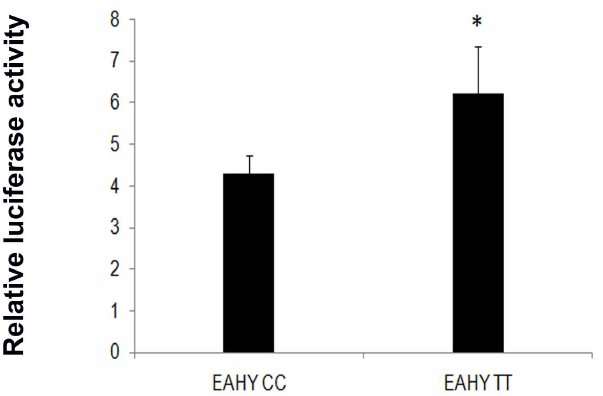
Figure 4. Effect of FoxC2 variant c.-512C . T (rs34221221) on luciferase expression in EA.hy926 cells. Cell lines were transiently transfected with the FoxC2 promoter reporter plasmid containing CC genotype or TT genotype. The renilla luciferase plasmid was co- transfected with reporter constructs to normalize the luciferase activity. Transfection with mutant construct (pGL4-TT) demonstrated a slight increase in luciferase activity (*p=0.051) compared to wild pGL4-CC construct. Data shown are the mean 6 SD of technical triplicates of two biological experiments.